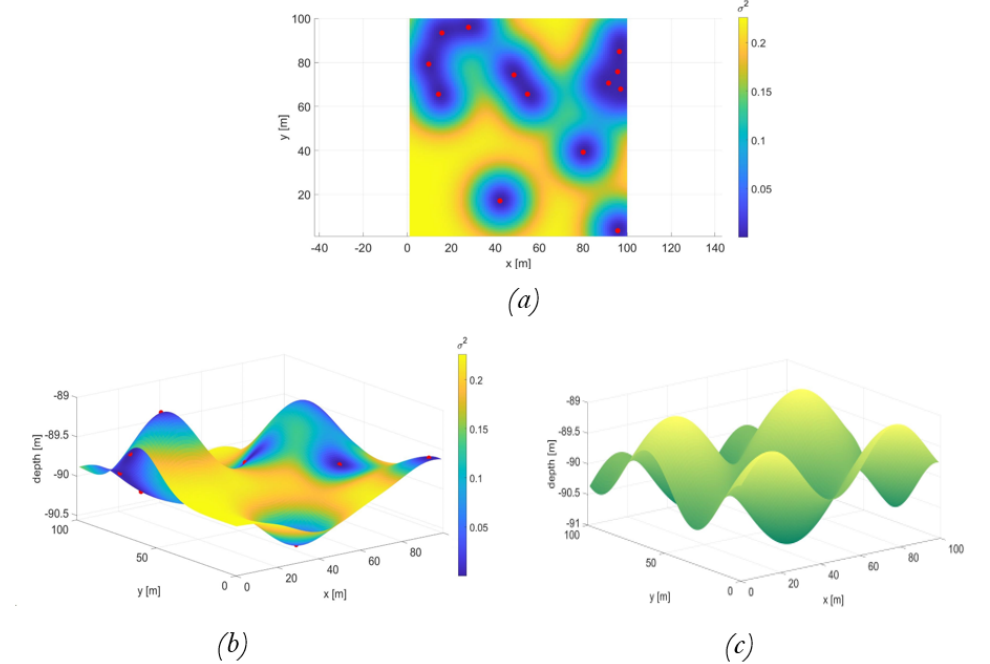
Figure 3. An example of a Gaussian Process applied to the study of seabed morphology. ( a ) shows the measurements as red dots and quantifies the variance according to a color map; the variance has a smaller value in the area around the measurement point than in the rest of the map. ( b ) illustrates the reconstruction of the bathymetric map based on the Gaussian process trained with the above- mentioned measurements. ( c ) determines the ground